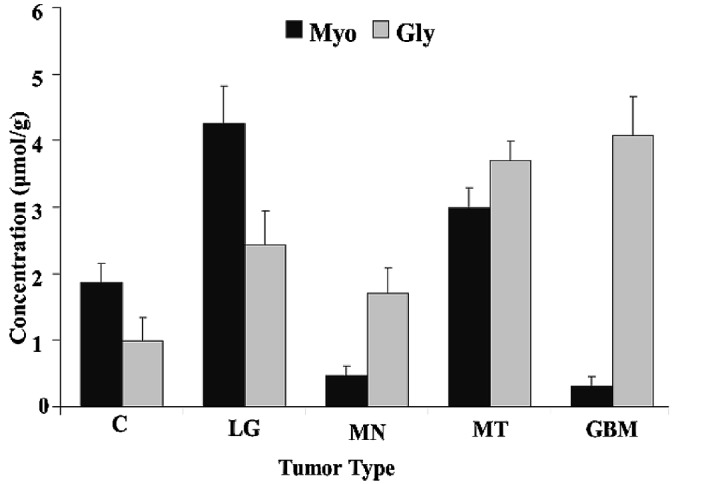
Gly and Myo levels distinguish control from brain tumor biopsies. Note that the major metabolite in GBM tumors was Gly whereas MT tumors contained substantial amounts of Myo. These data provide a clinically important distinction between MT and GBM.